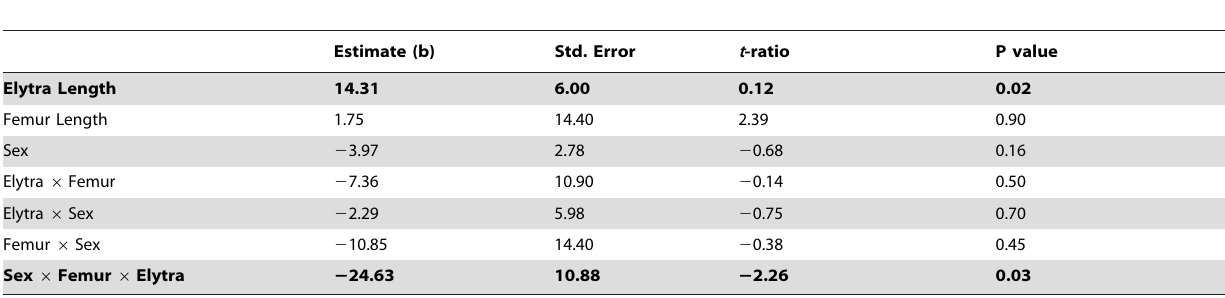
Table 2. Parameter estimates and significance values for fully justified GLM predicting grip strength (N=61). Bold variables were significant ( a